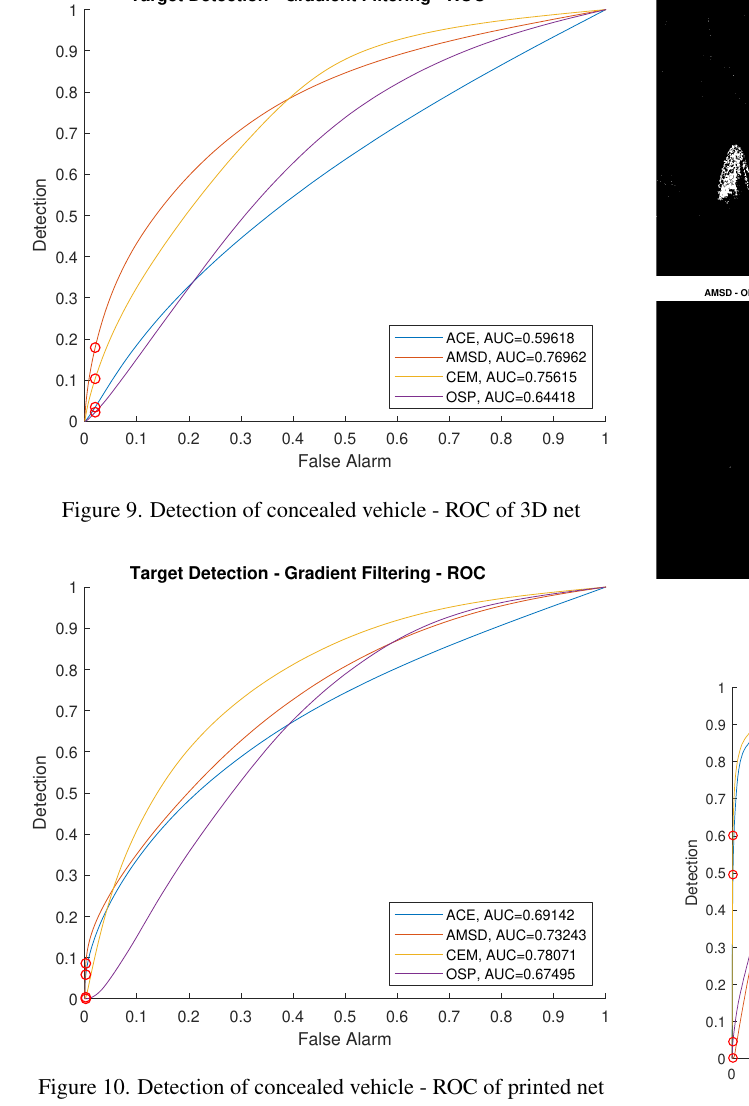
Figure 10. Detection of concealed vehicle - ROC of printed net